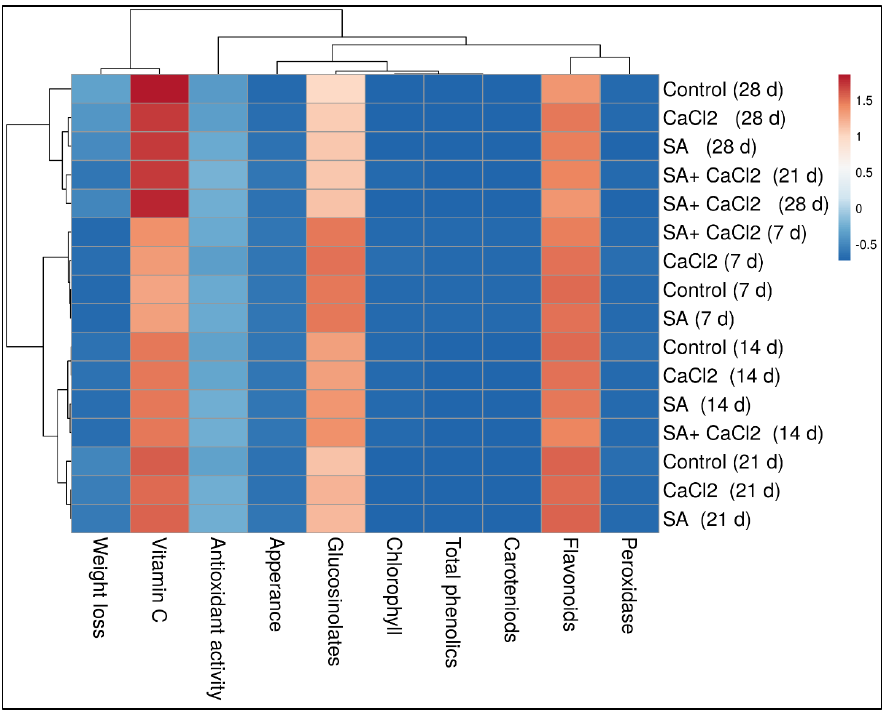
Figure 6. Two-dimensional heatmap visualization shows the interaction between the postharvest exogenous SA and CaCl 2 treatments and both the measured parameters measured in this study. Lower numerical values are colored blue, whereas higher numerical values are colored red.